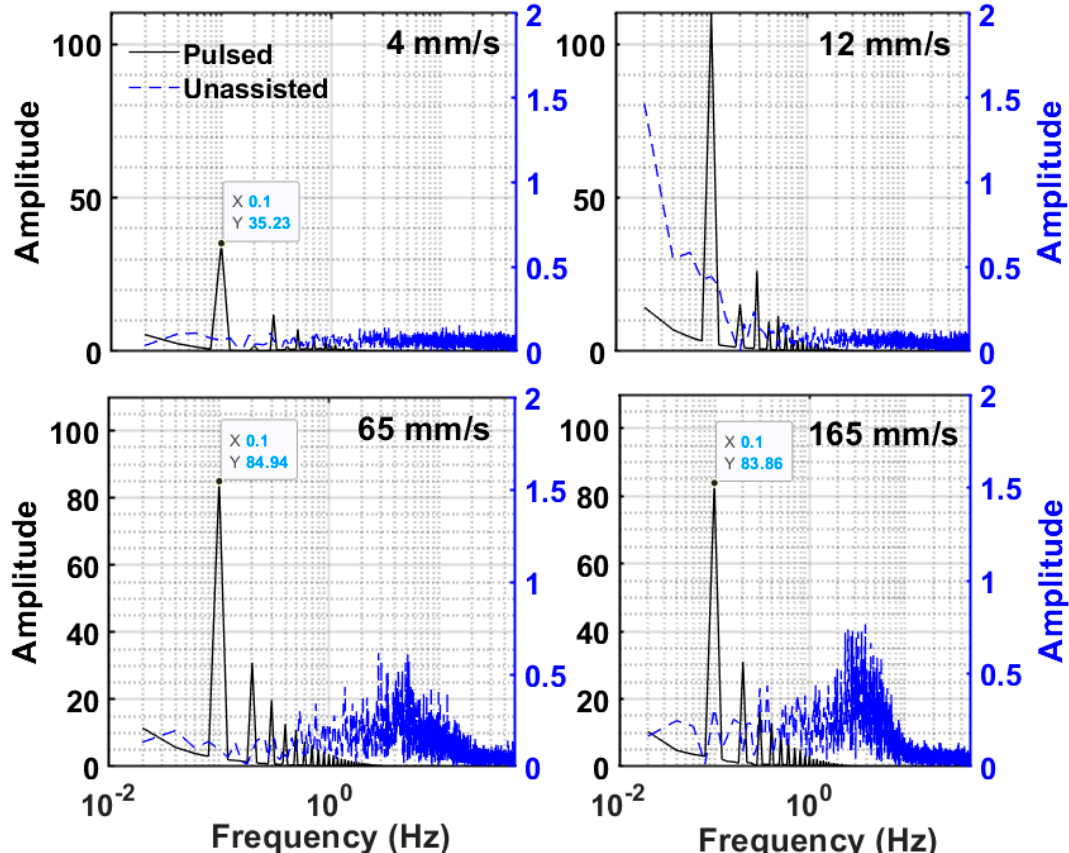
Figure 9. Overall bed dynamics at different velocities for unassisted and pulsed fluidizations.